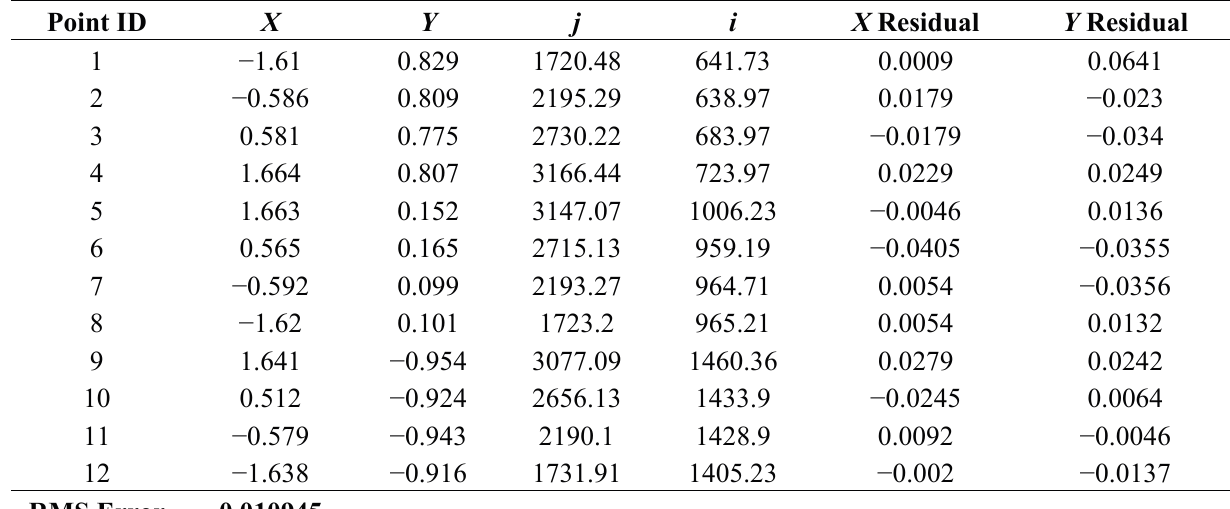
Table 7. Ground, image coordinates and their ground residuals of the original GoPro